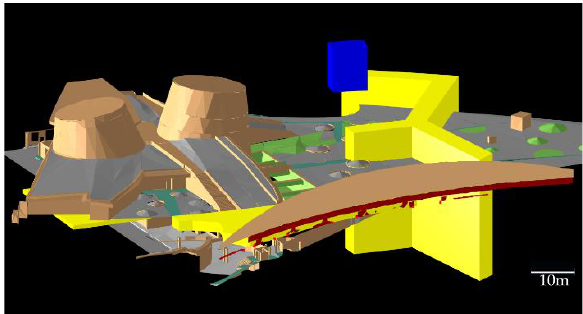
Figure 1: Virtual 3D model of the Planetarium Rio Tinto Alcan (Montreal city) in which easements are represented in yellow, buildings and urban facilities in brown, ground in grey and green spaces in green. A 3D object (in blue) has been added as an example of RRR conflict with an existing easement (source: Geomatics Division, Montreal City).